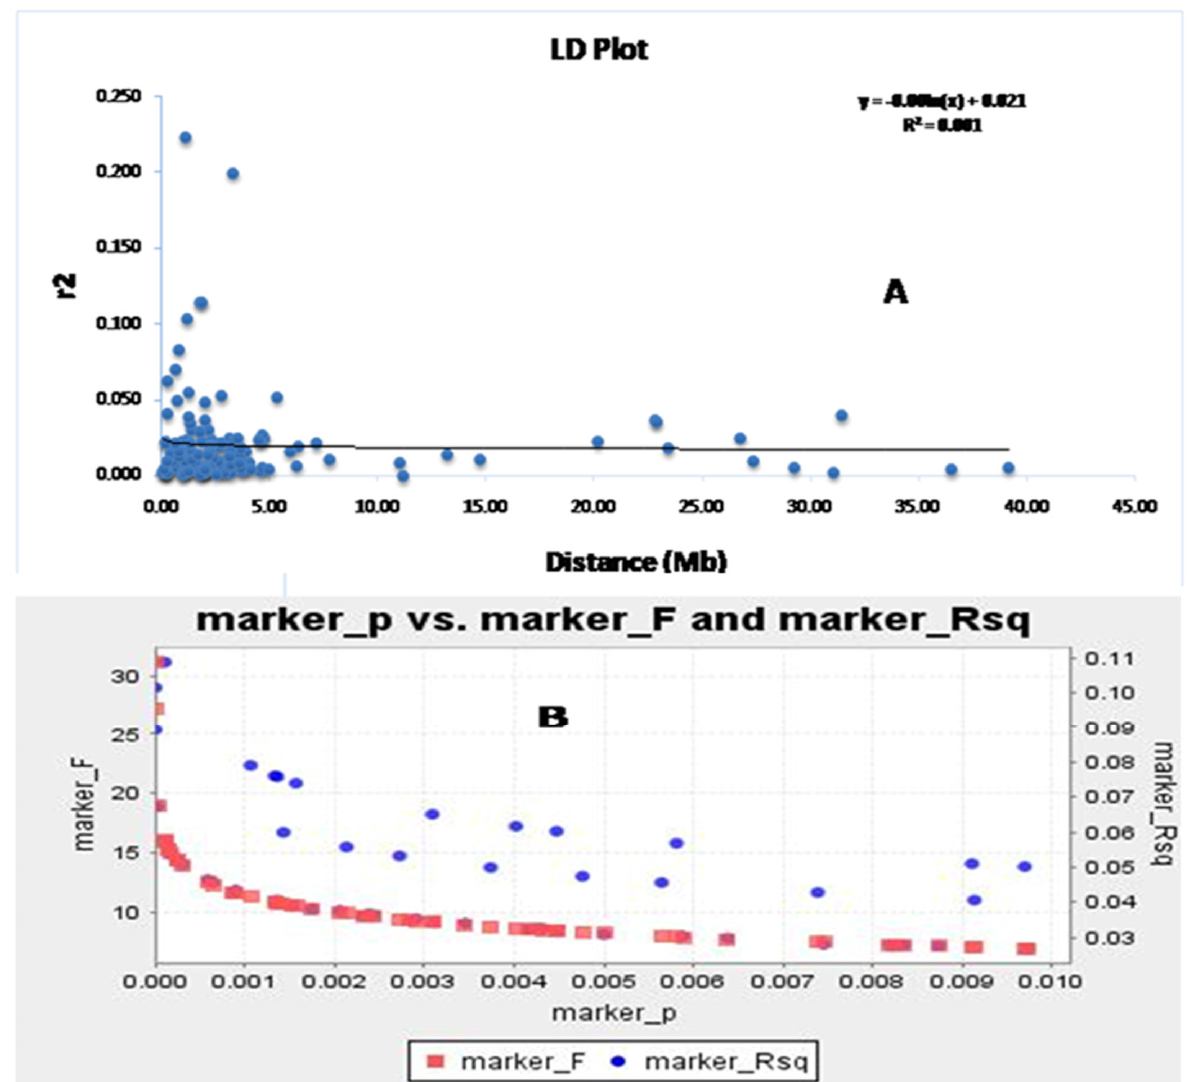
Figure 5. The marker ‘P’ versus marker ‘F’ and marker R 2 detected using ( A ) the GLM approach and ( B ) the physical distance (Mb) between pairs of marker loci on chromosomes vs. a linkage disequilibrium decay ( r 2 ) curve plotted in rice. The decay started in million bp estimated by considering the 95th percentile of the distribution of r 2 for all unlinked loci.